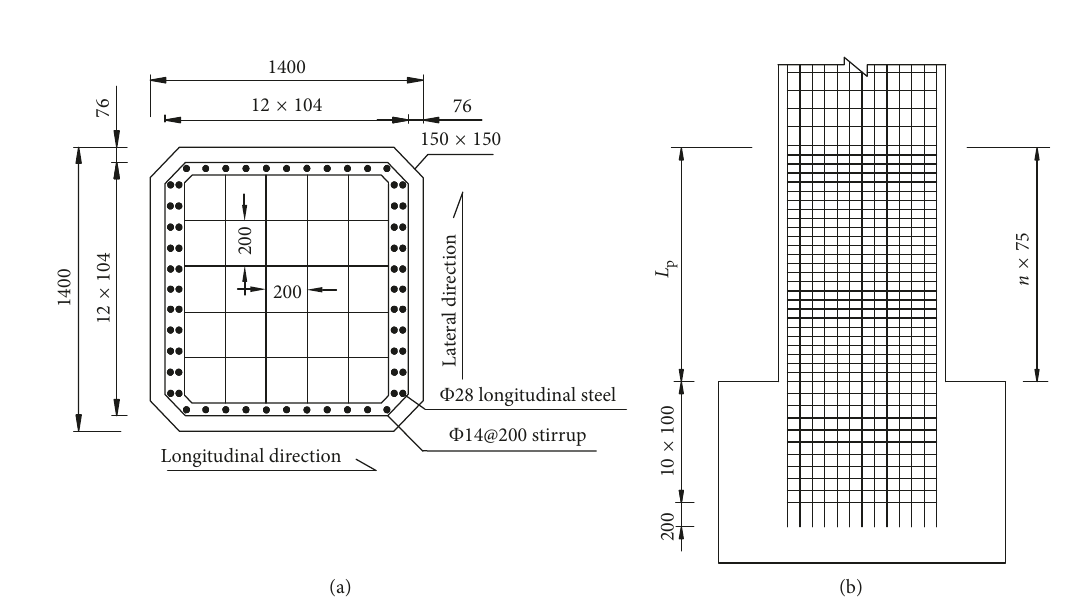
Figure 4: Cable displacement restrainers [18].